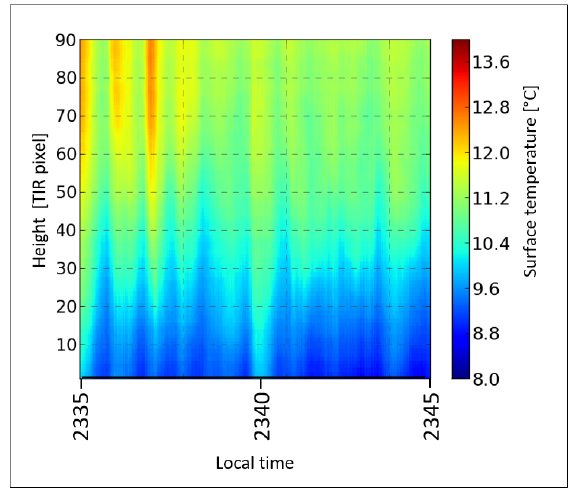
Figure 6. Profile diagram of TIR profile 1 (location in Figure 5) with 90 TIR data points (pixel) for a height of 150 cm starting at 20 cm above ground, 10-min cold-air pulse period measured on 23 July 2012 from 23:35 to 23:45 LT.